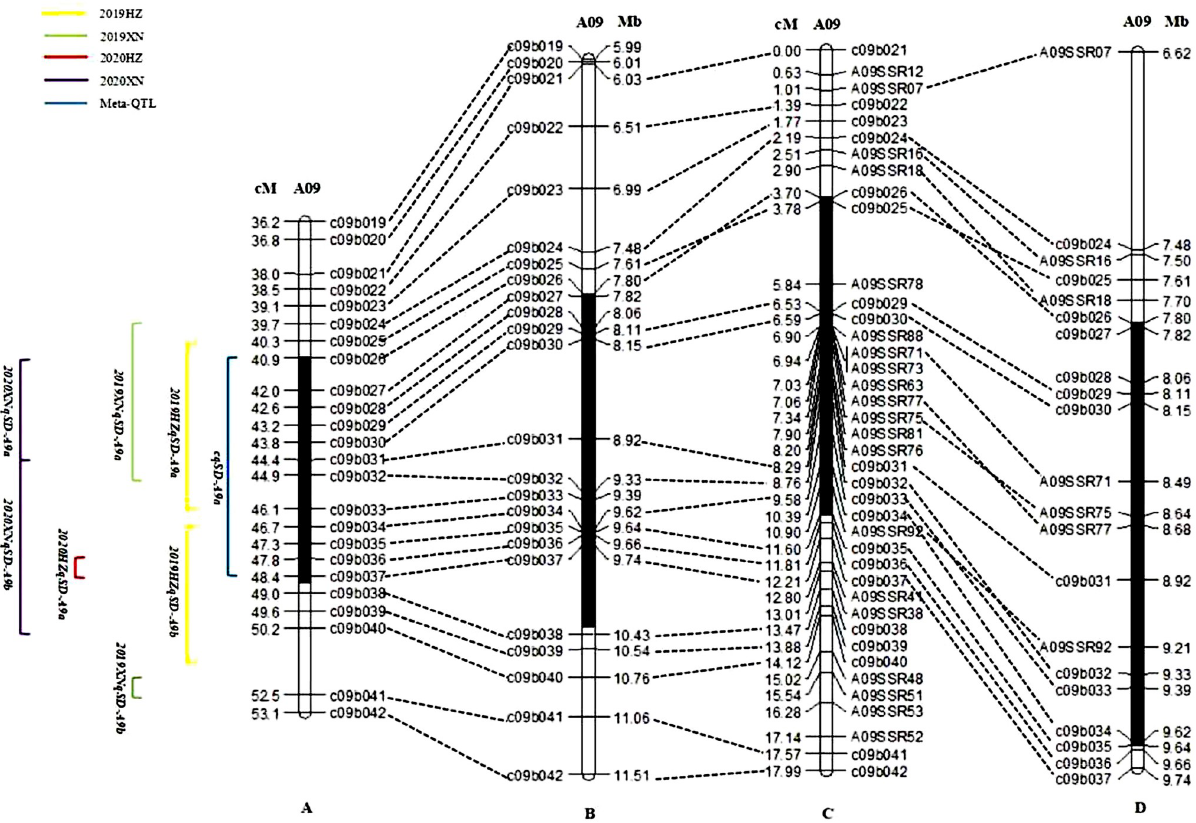
Fig 5. Map of flanking markers of major loci. (A) Mapping of SD QTLs in B . napus . (B)Mapping of physical bins within the candidate intervals. (C) Genetic position mapping after candidate interval markers. (D) Mapping of the physical location of candidate interval markers. Note: The black solid lines represent the SD QTL mapping intervals; the yellow lines represent the confidence intervals of the QTLs in 2019HZ; the green line represents the confidence interval of the QTL in 2019XN; the red line represents the confidence interval of the QTL in 2020HZ; the purple line represents the confidence interval of the QTL in 2020XN; and the blue line represents the QTL confidence interval according to the results of a meta-analysis.